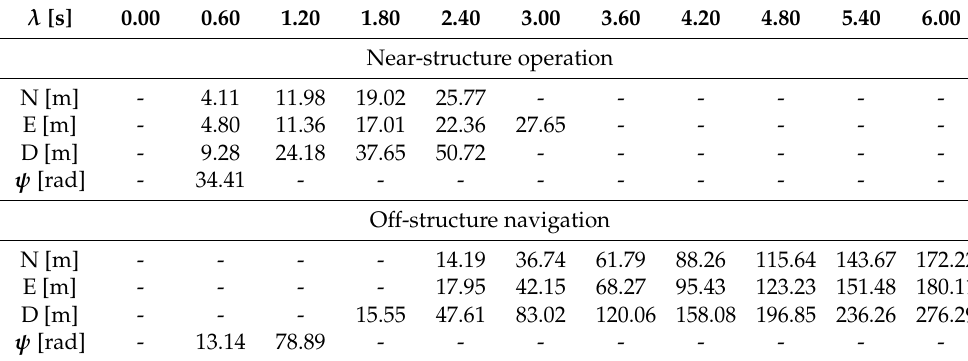
Figure 16. (cid:107) KS (cid:107) ∞ , min for off-structure navigation. Table 10. Selected values for (cid:107) KS (cid:107) ∞ ,